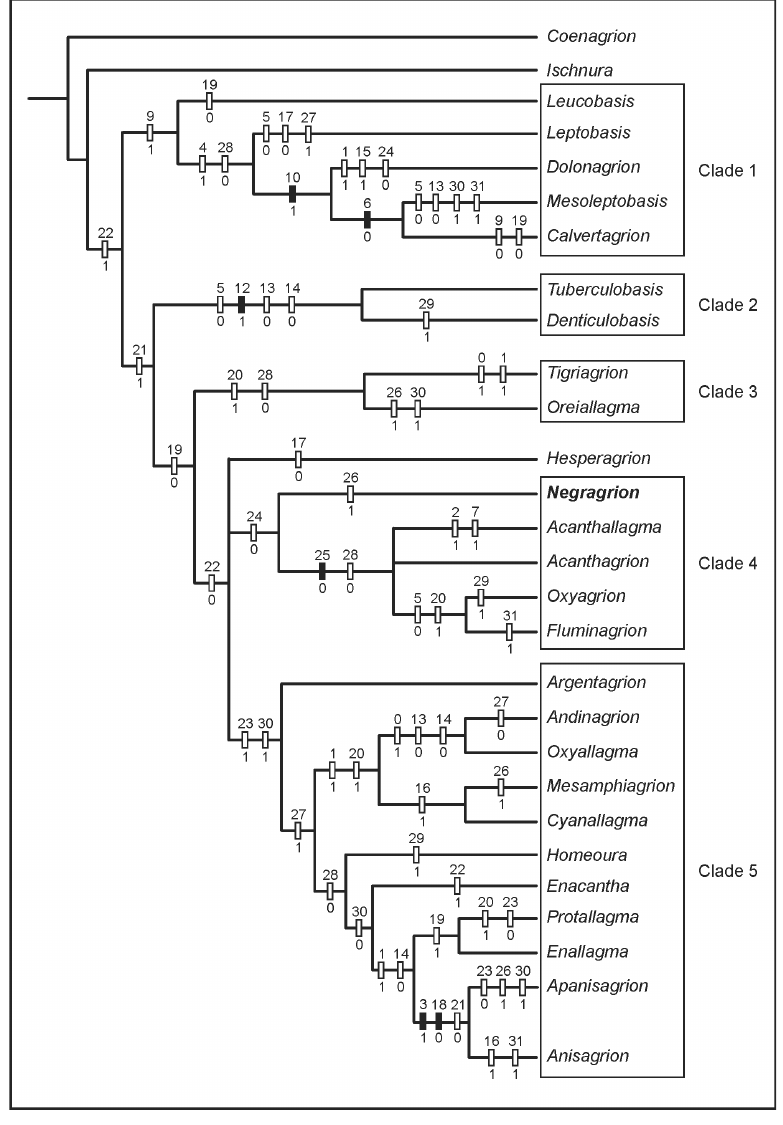
Figure. 4. Tree topology obtained from the phylogenetic